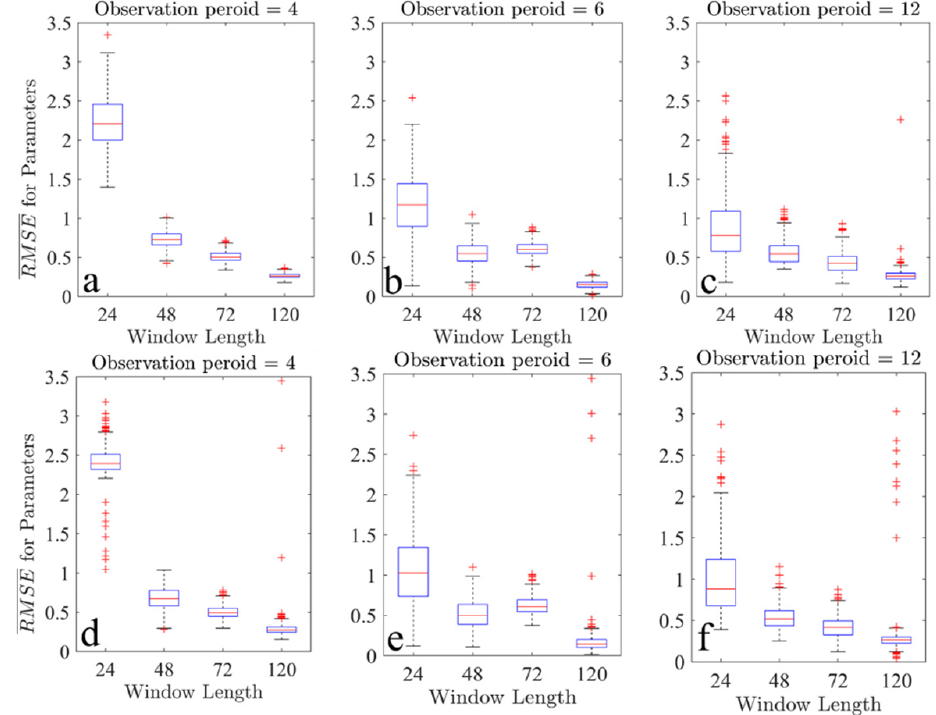
Figure 5. The effect of assimilation window lengths and observation periods on the RMSE for parameters. ( a – c ) the box plot for A-4DEnVar and ( d – f ) for 4DVar. The symbols of box plot are the same as those in Figure 4. The outliers are marked as red +.